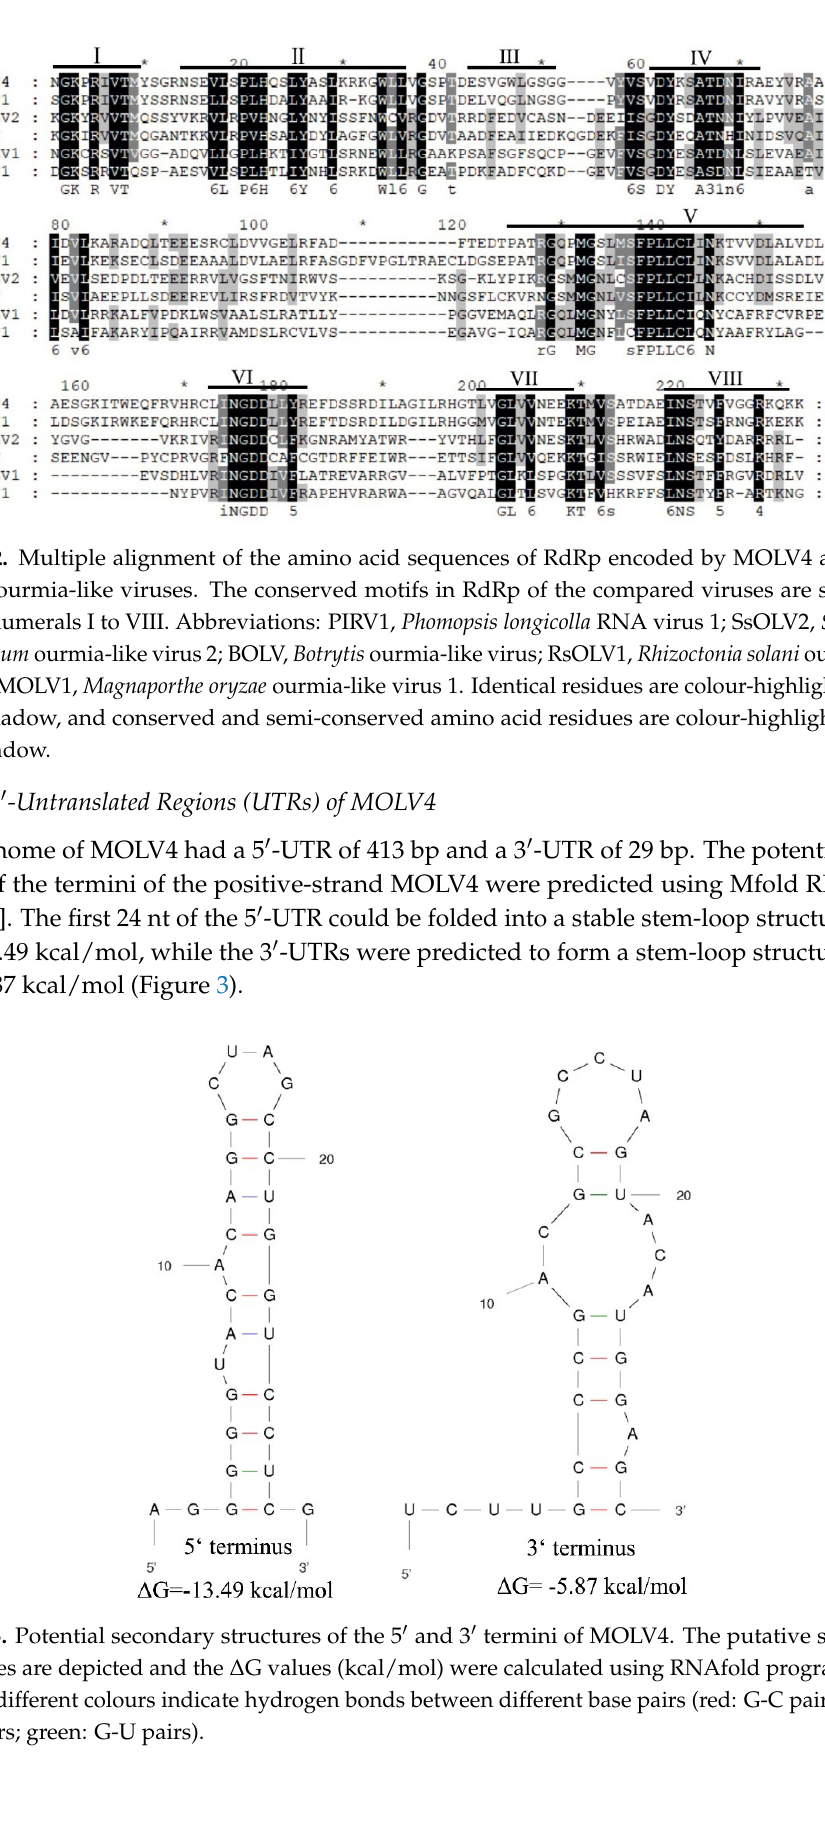
Figure 3. Potential secondary structures of the 5’ and 3’ termini of MOLV4. The putative stem-loop structures are depicted and the ΔG values (kcal/mol) were calculated using RNAfold program. Short lines in different colours indicate hydrogen bonds between different base pairs (red: G-C pairs; purple: A-U pairs; green: G-U